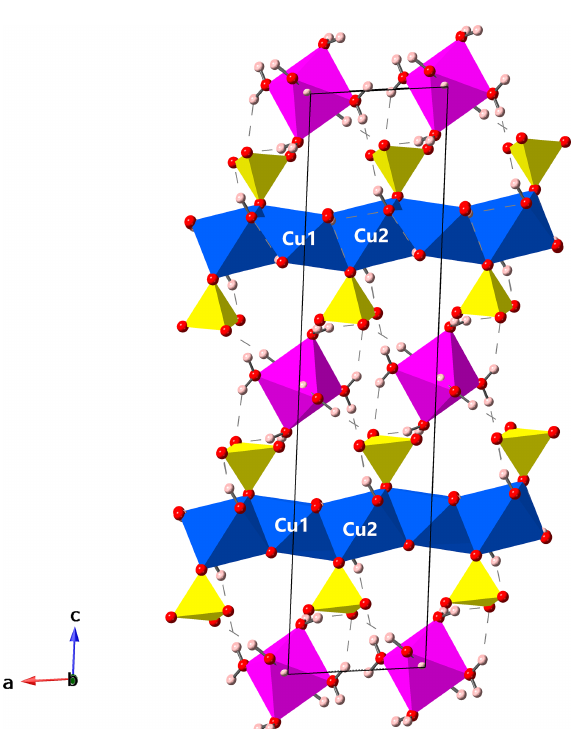
Figure 3. Crystal structure of gobelinite from Cap Garonne in a view along [010], parallel to the brucite-like sheets. Jahn–Teller- distorted CuO 6 octahedra (blue), regular CoO 6 octahedra (ma- genta), SO 4 tetrahedra (yellow), O atoms (red) and H atoms (pale pink). The unit cell is outlined. Hydrogen bonds are shown as dashed lines. Drawing done with CrystalMaker (Palmer,